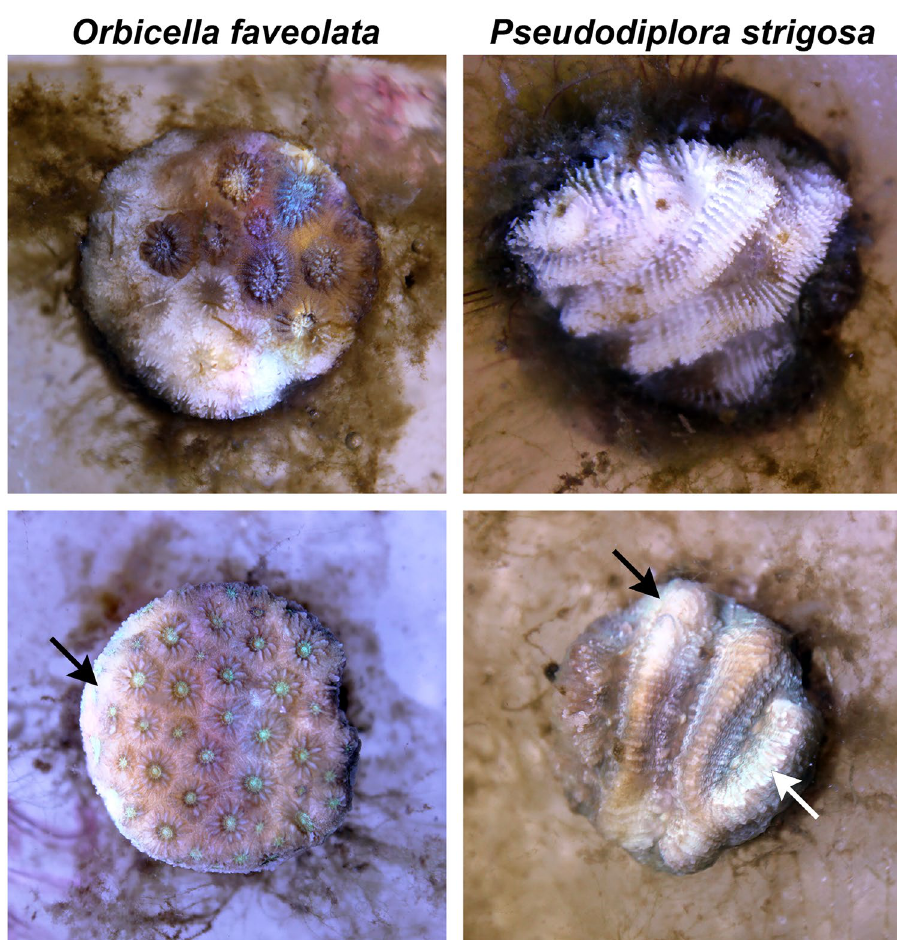
Figure 3. Representative photos of disease lesions. Orbicella faveolata (left) and P. strigosa (right) fragments following contact with disease-exposed water. Orbicella faveolata fragments typically exhibited rapid onset of necrosis/tissue loss following initial exposure to SCTLD (top left) and/or paling/bleaching margins (bottom left, indicated by arrow). Pseudodiploria strigosa fragments demonstrated rapid (< 24 h) progression of tissue loss once lesions were first observed (top right), with less frequent occurrence of paling/bleaching lesions (bottom right, indicated by arrows).